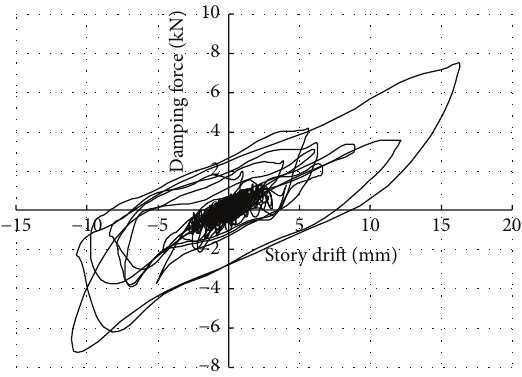
Figure 10: Hysteretic loop of interaction force of the test structure at the 1st floor under excitation of scaled-down Kobe earthquake with PGA = 0.862 m/sec 2 (86.2 gal).